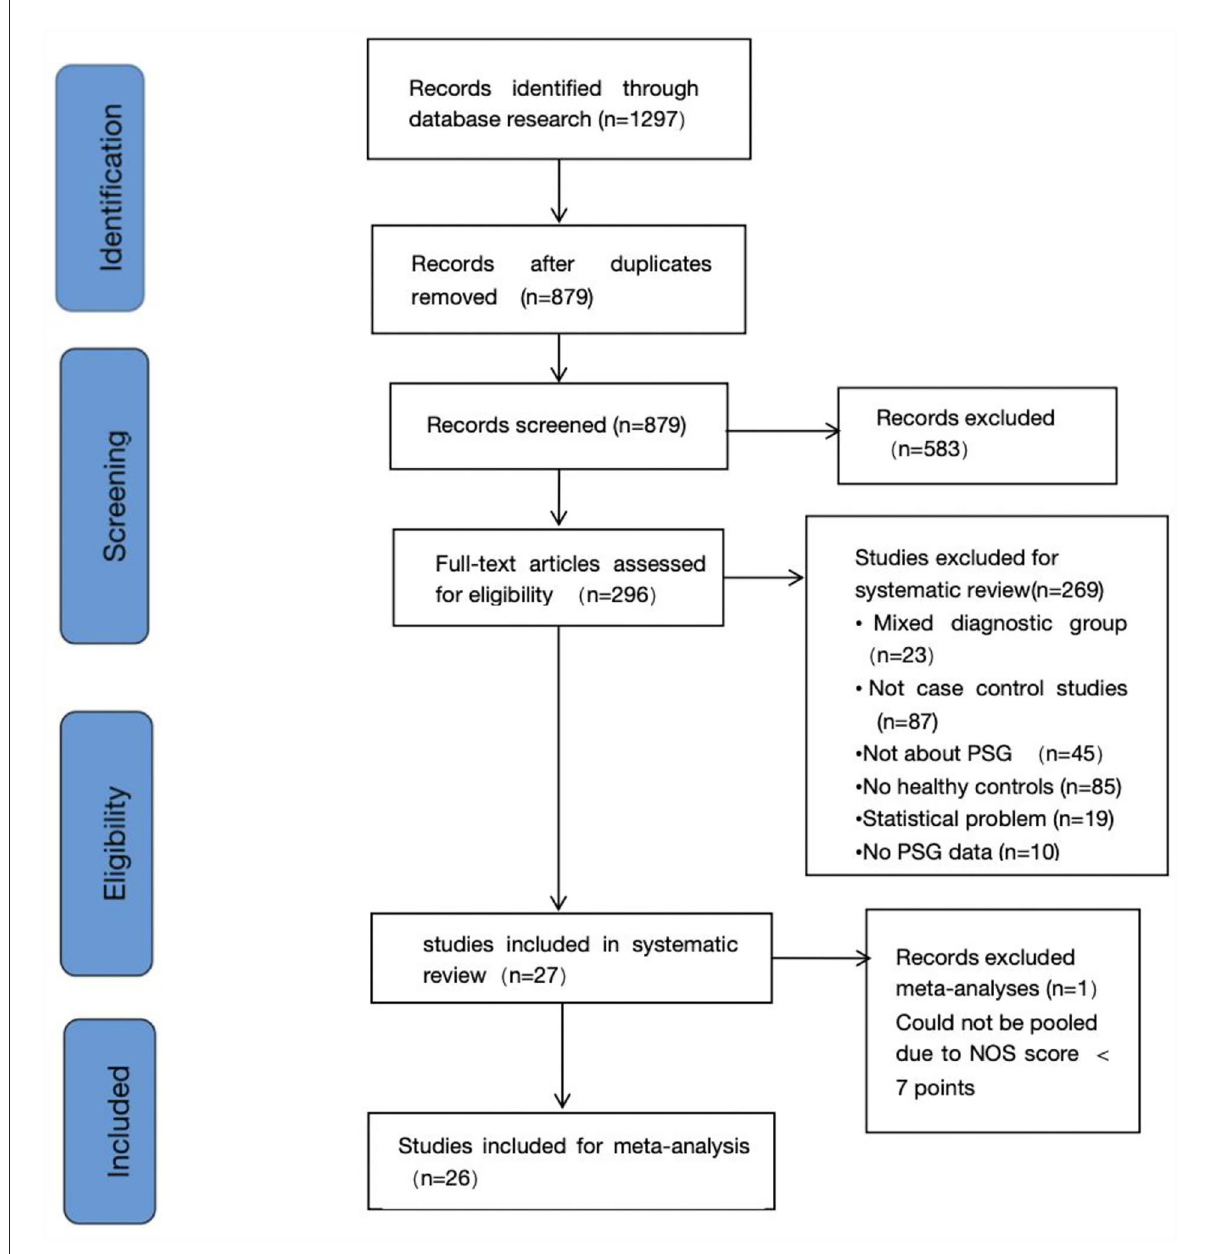
FIGURE1 Flow diagram of the studies